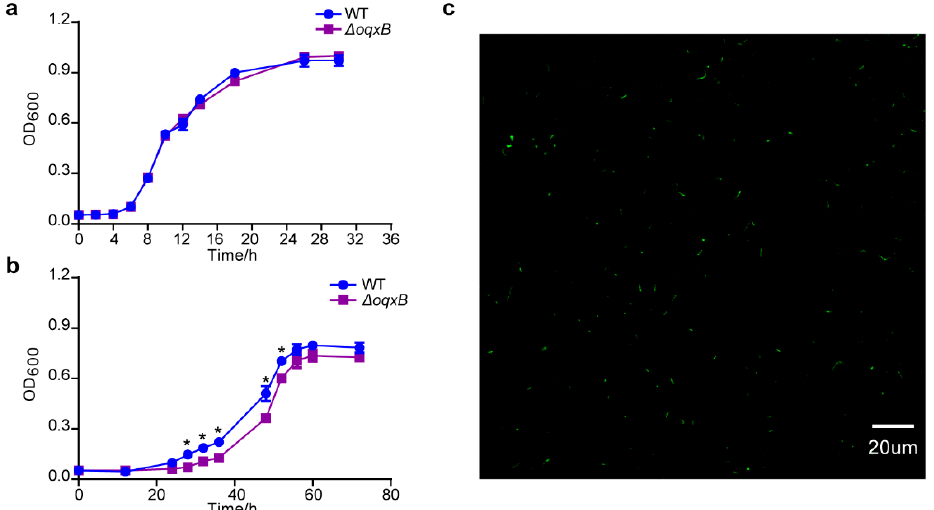
Figure 5. Application of the pCasPA/pACRISPR system − mediated gene editing in the characterization of P. fulva . ( a ) No significant differences were observed between wild type and the Δ oqxB mutant when grown under normal conditions. ( b ) Compared to the wild type, the growth of the Δ oqxB mutant significantly slowed down when cultured in LB containing the antibiotic chloramphenicol. ( c ) The fluorescence of the P. fulva::gfp mutant after gfp insertion. ∗ , representing significant difference ( p < 0.05).